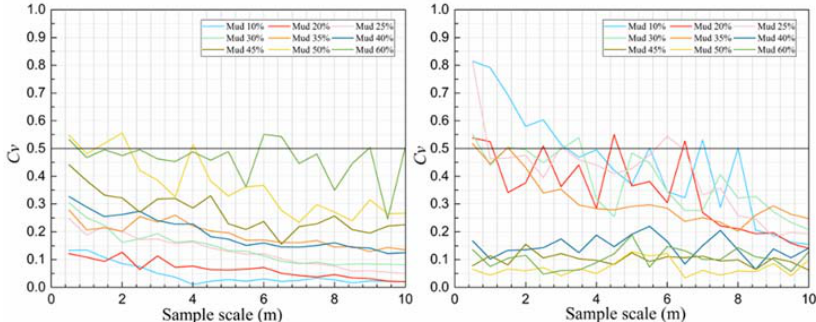
Figure 11. Cv curves for ISWZs with constant width: vertical permeability ( right ) and horizontal permeability ( left ).